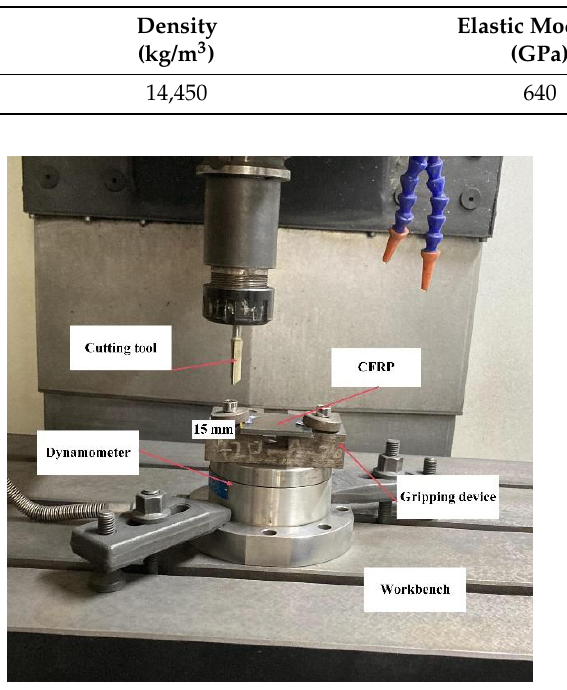
Table 4. Tool material parameters [21].